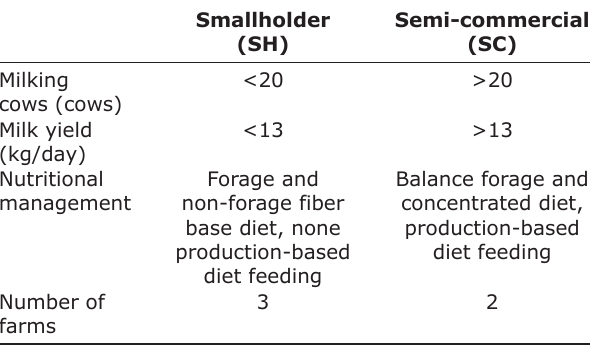
Table-1: Classification of farm type. Smallholder